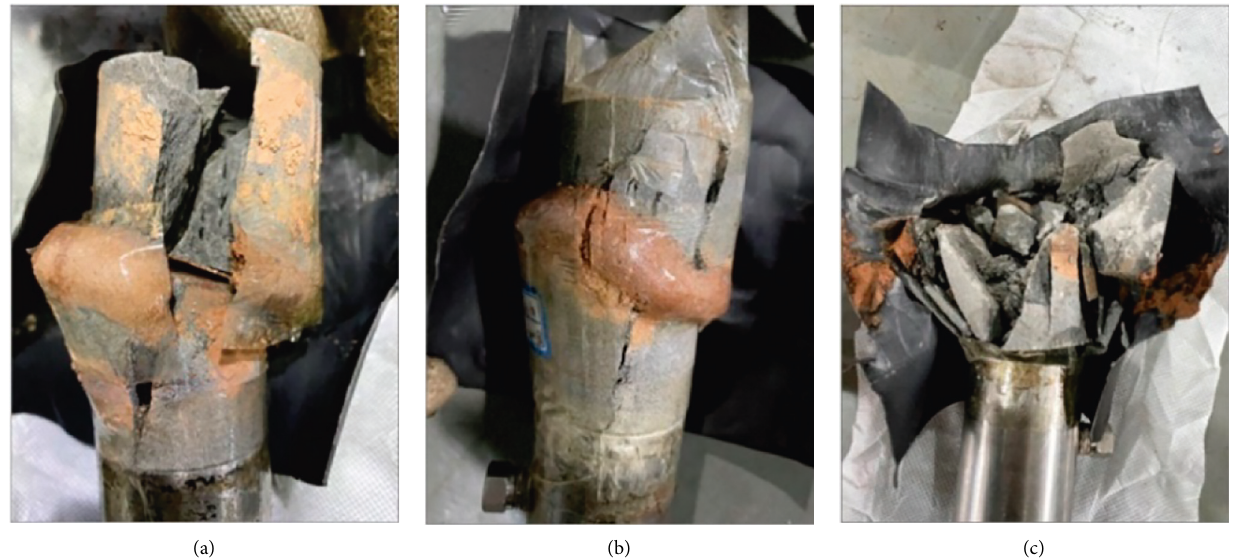
Figure 16: Fracture evolution characteristics of fine sandstone specimens under different confining pressures: (a) confining pressure 1MPa, (b) confining pressure 2MPa, and (c) confining pressure 3